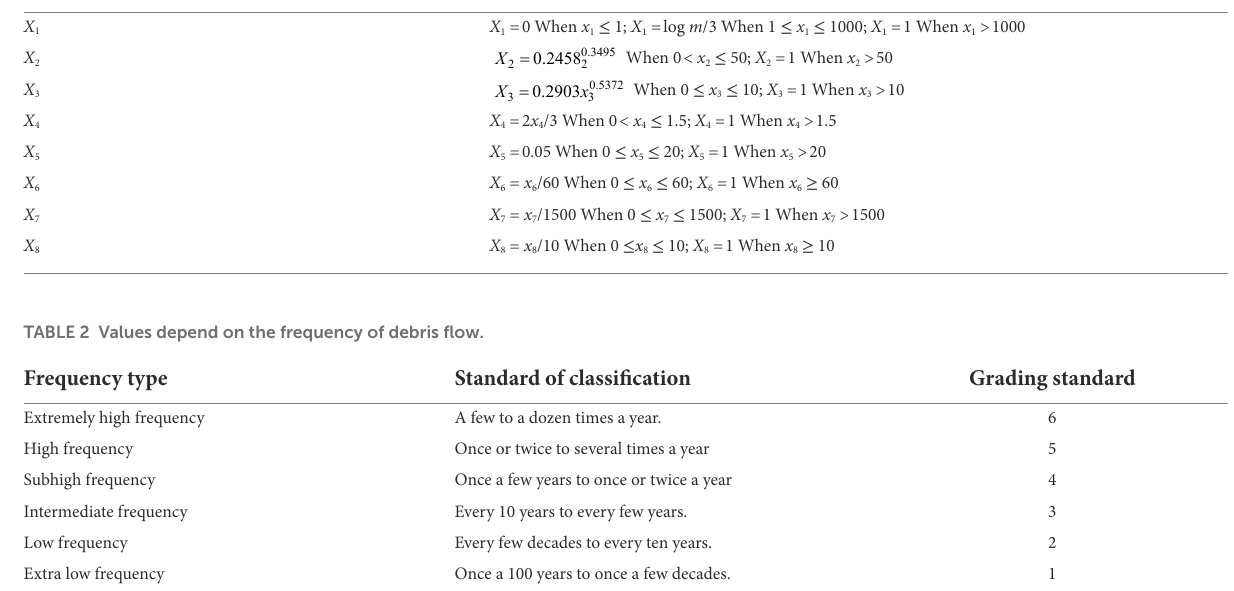
TABLE 1 The conversion function of the impact factor. Transformation value (0 ~ 1)